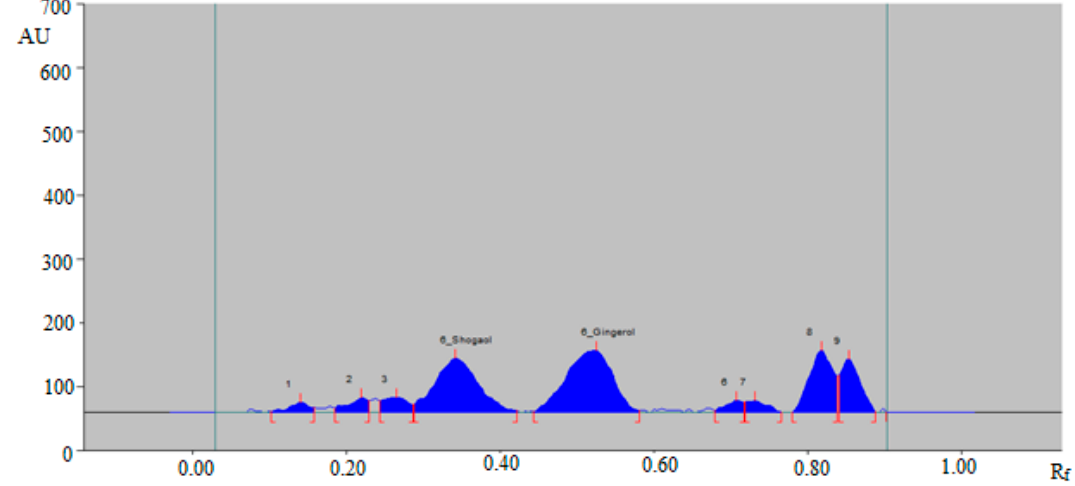
Figure 4. HPTLC-densitogram of 6-SHO and 6-GIN in traditional ginger rhizome extract.